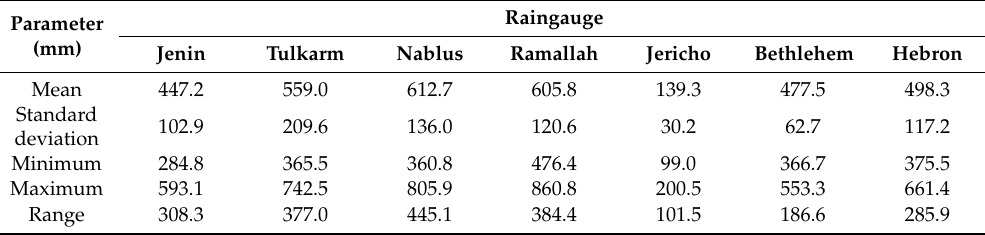
Table 1. Basic statistics of annual rainfall data for selected raingauges (for the period